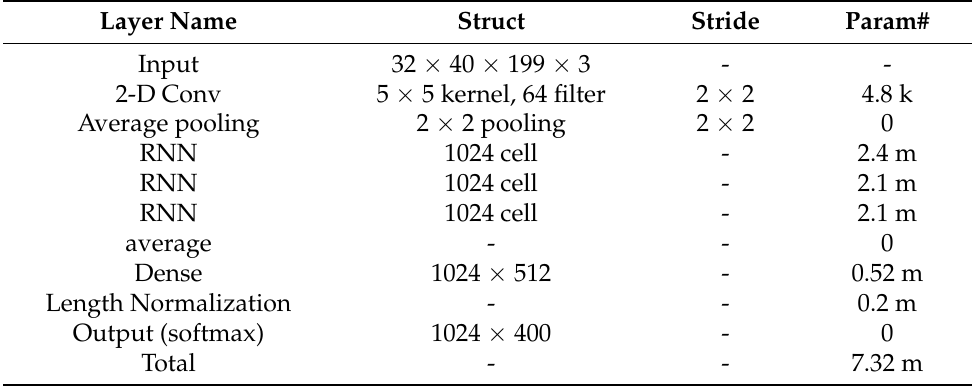
Table 4. The details on deep CNN + traditional RNN network